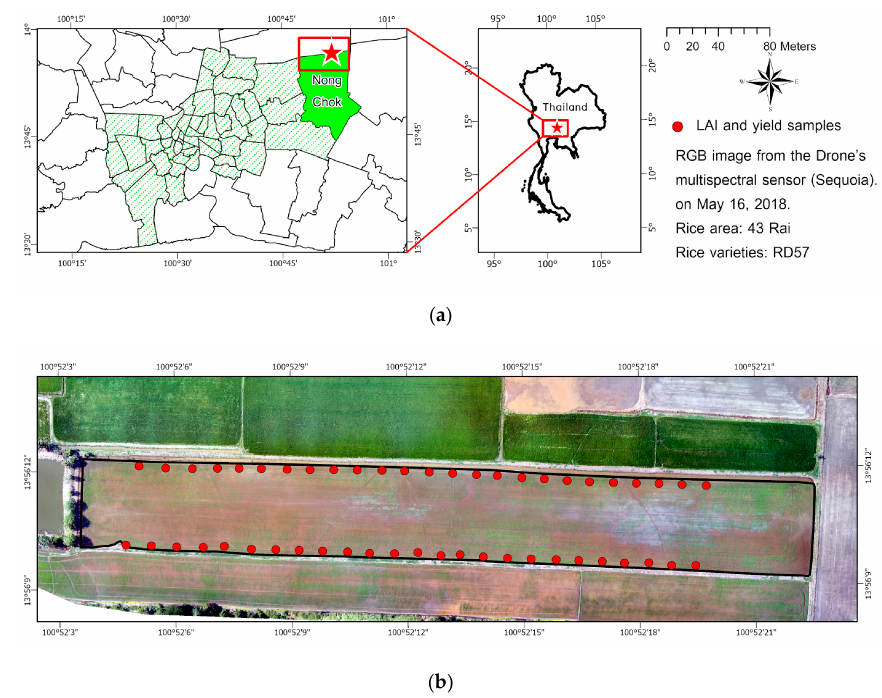
Figure 2. ( a ) The test site (indicated by a red star) located in northeast Bangkok. ( b ) True-color image of the site, taken by a DJI Phantom 3 advanced equipped with a Parrot Sequoia multispectral camera at 10 cm ground spatial distance (GSD). Red dots on the periphery represent 50 sample plots.